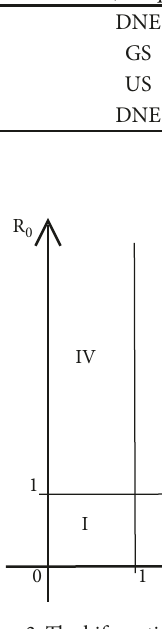
Figure 3: The bifurcation diagram in ( 𝑄 0 , 𝑅 𝑐 0 ) plane. The stability of equilibria in each region is given in Table